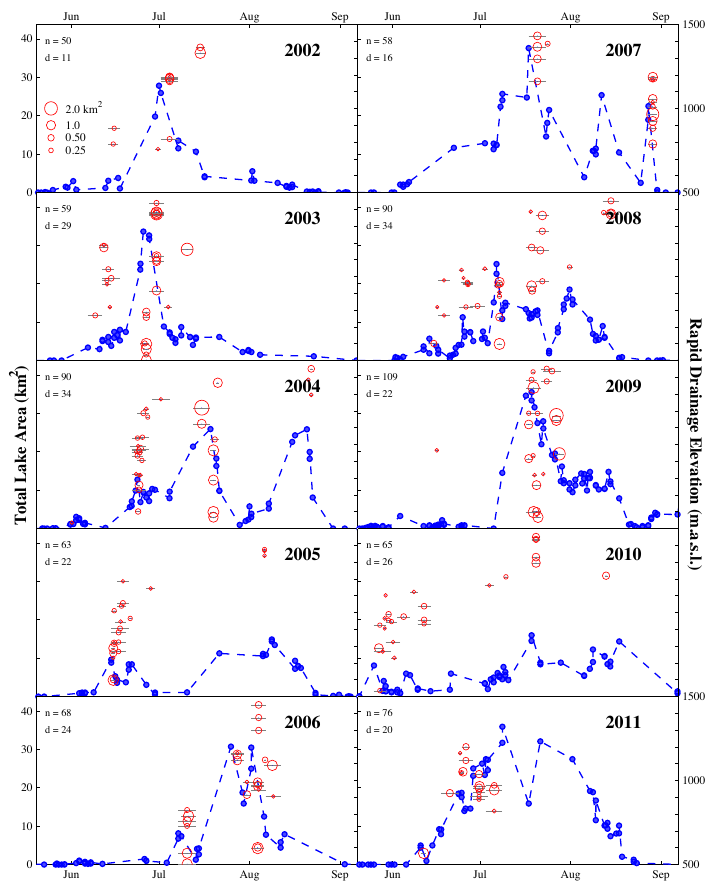
Fig. 4. Evolution of total lake surface area (blue squares) for all valid ETM + and MODIS scenes ( n) for each year of the study. Rapid Figure 4. Evolution of total lake surface area (blue squares) for all valid ETM+ and 2 drainage events (red circles) appear at the affected lake’s elevation and are sized relative to magnitude (km 2 , see legend in 2002 panel) – d represents the total number of drainages for any year. All plots share axes, detailed in 2002, 2006, 2007, and MODIS scenes ( n ) for each year of the study. Rapid drainage events (red circles) appear 3